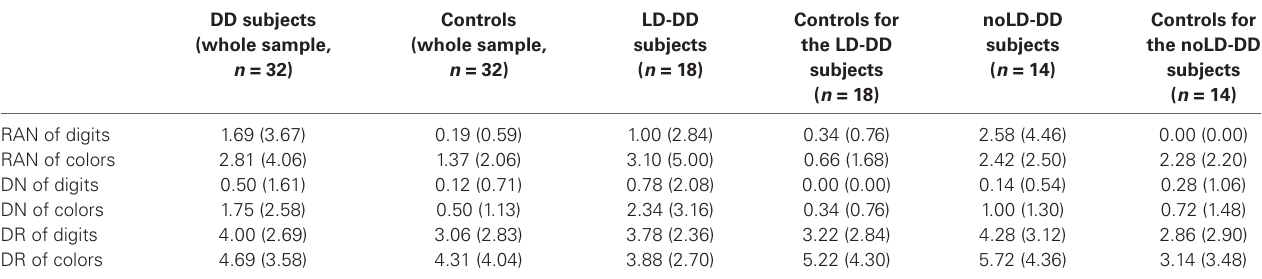
Table 3 | Mean percentages of errors and SDs (in brackets) of the whole DD sample, of the sub-groups of DD participants with (LD) and without (noLD) a history of language delay and the respective control groups on the three experimental tasks as a function of type of stimulus (digits and colors)